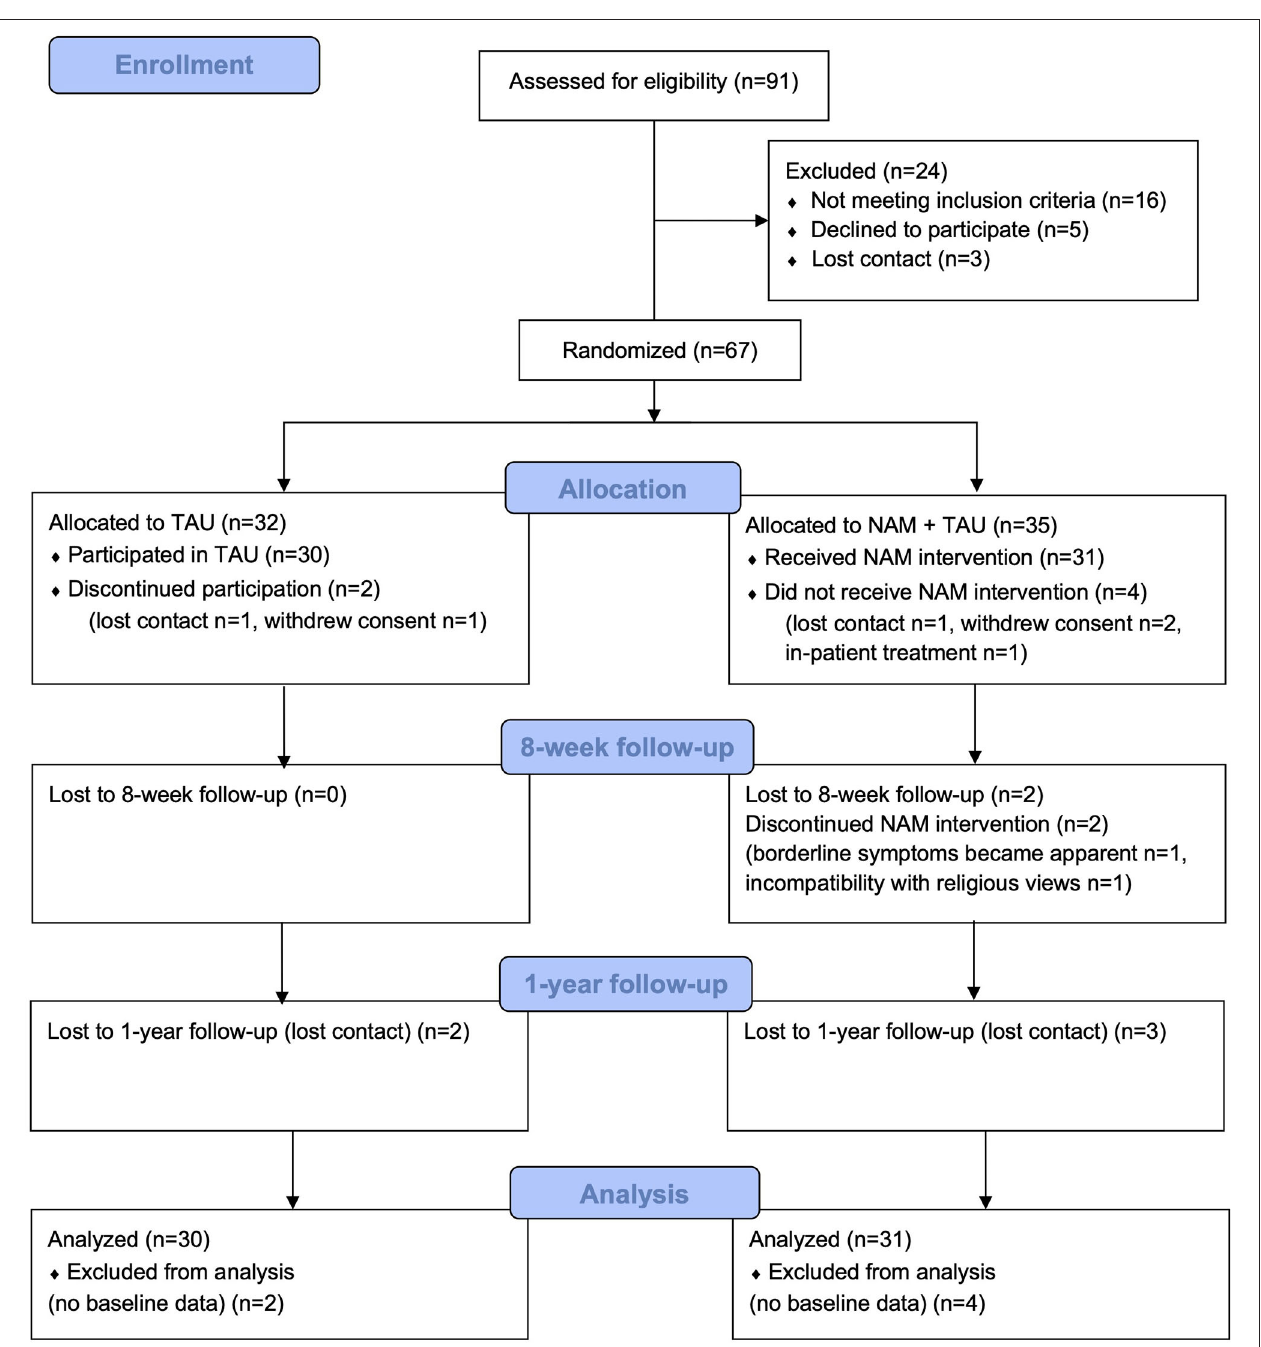
FIGURE 1 | Consort diagram of participant